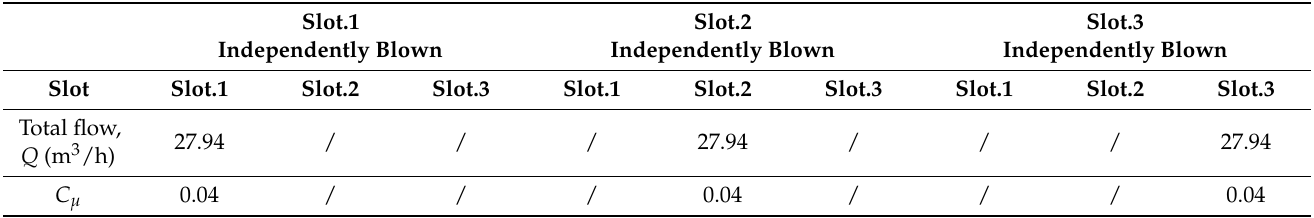
Table 4. Experimental parameters of independent blowing of three slots.